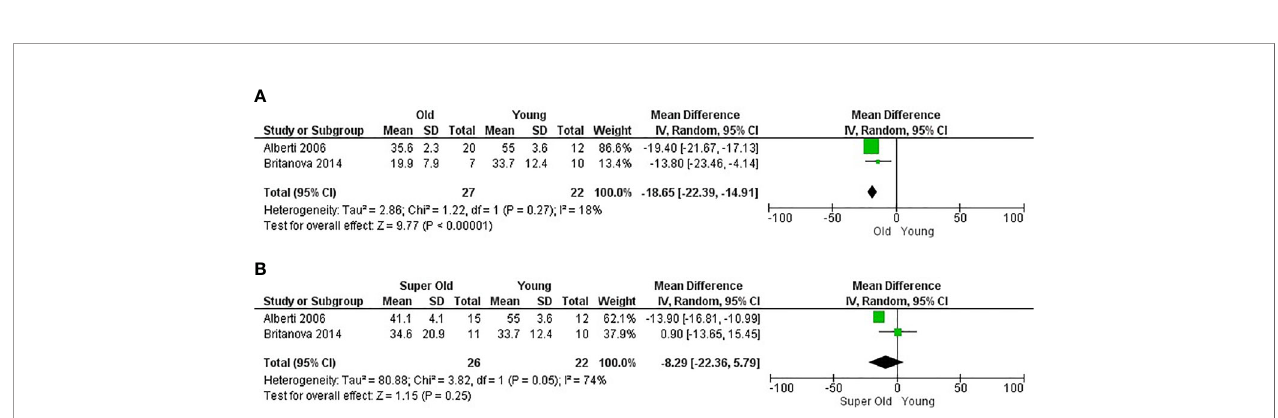
FIGURE 5 | In fl uence of age on naive CD4+ T cell frequency. Forest plot for the different outcomes regarding cell frequency. (A) Changes in the frequency of CD4+ naive T cells between old and young groups and (B) Changes in the frequency of CD4+ naive T cells between super old and young groups.